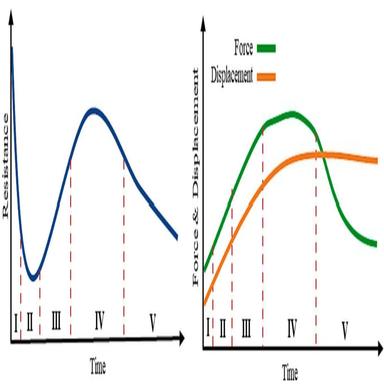
5-Phase Dickenson model: (left) DR curve, (right) force and displacement curves.